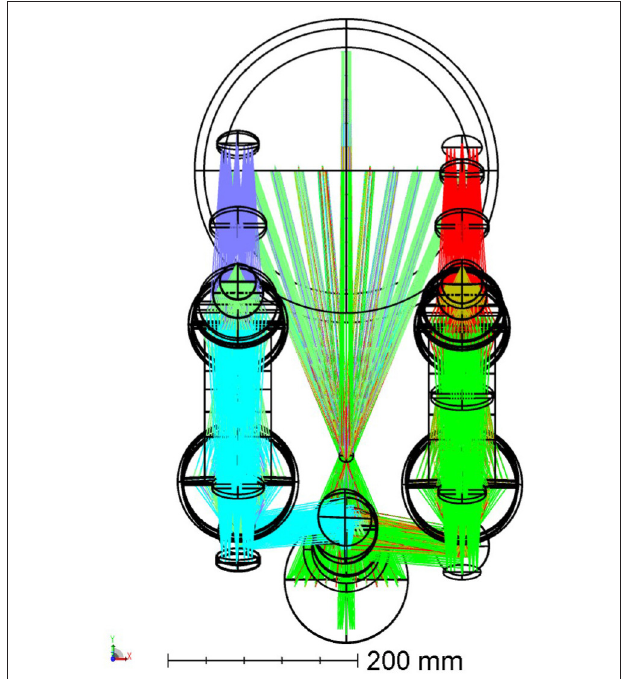
FIGURE 4 | ZEMAX front view of